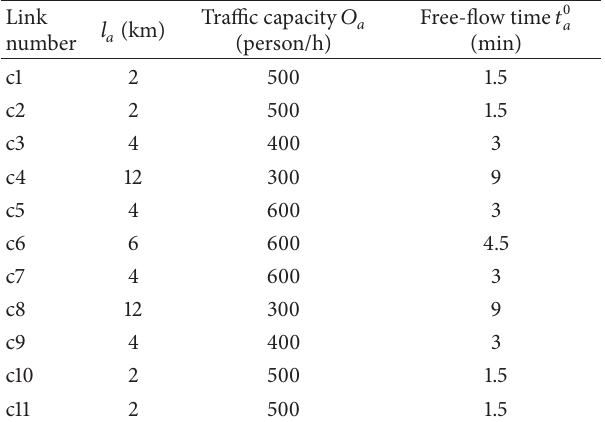
Table 1: Physical properties of car network.